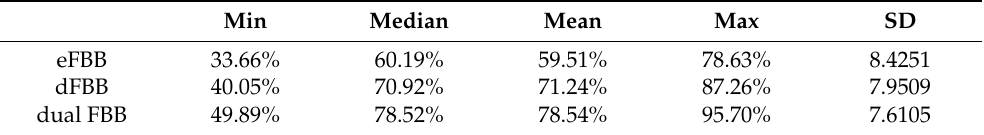
Table 3. Summary statistics of Figure 5.